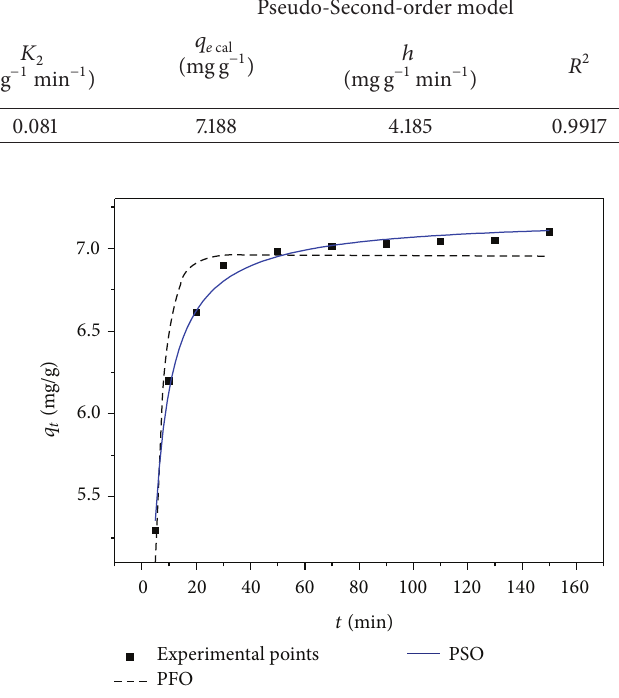
Figure 4: Effect of initial pH on the removal of Cd(II) on WAS.